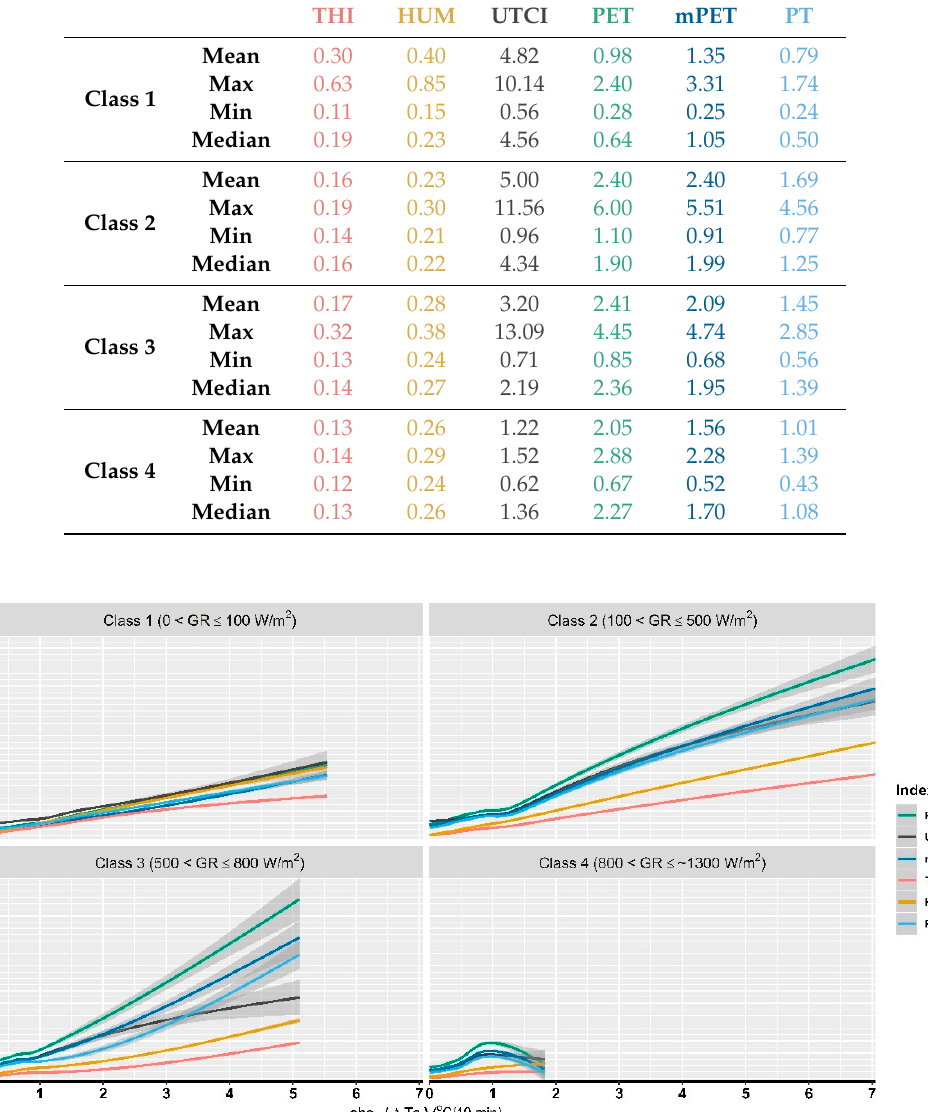
Table 10. Descriptive statistics of the indices’ sensitivity to Air Temperature (T a ) change rates under different Global Radiation (GR) conditions.